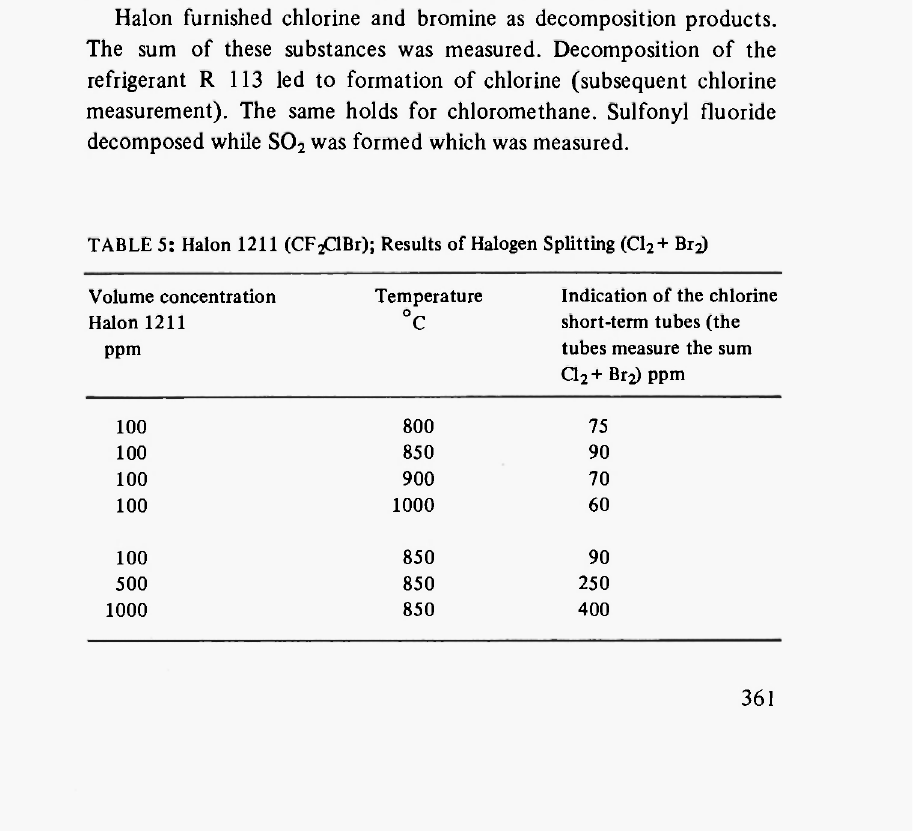
TABLE 5: Halon 1211 (CFjClBr); Results of Halogen Splitting (Cl 2 + Β Γ2